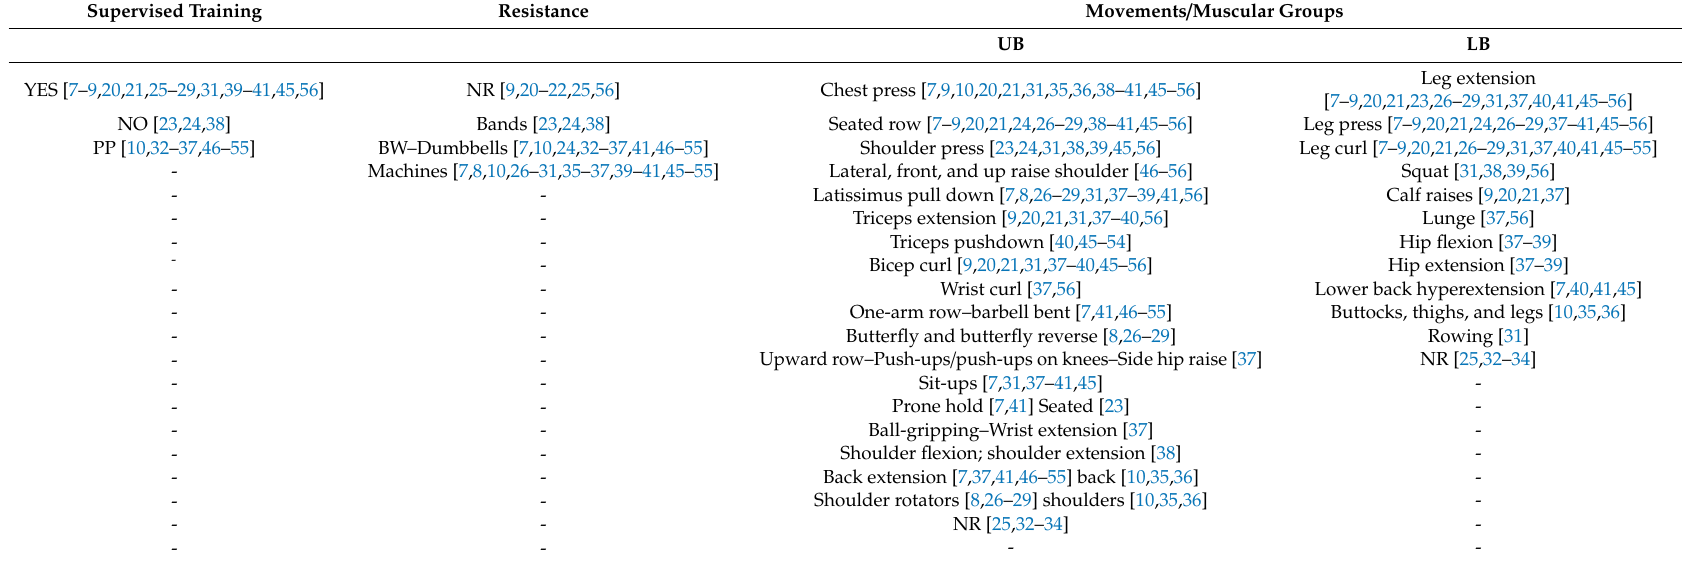
Table 9. Muscular Groups